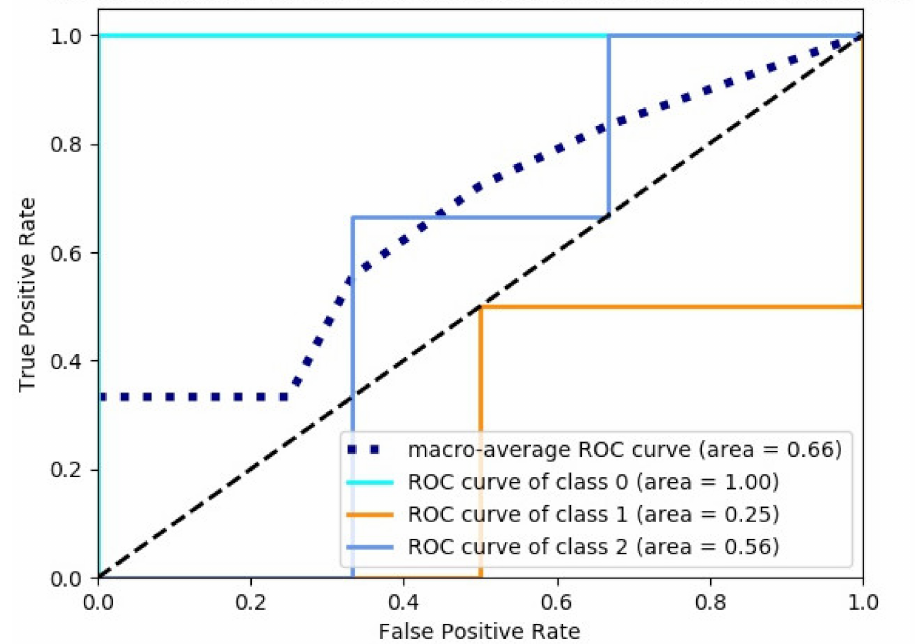
Figure 11. SVM classification model ROC curve and area under the ROC curve.